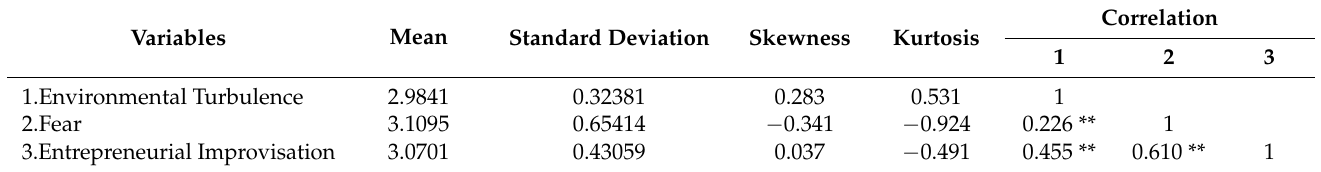
Table 2. Descriptive statistics, normality tests, and correlation